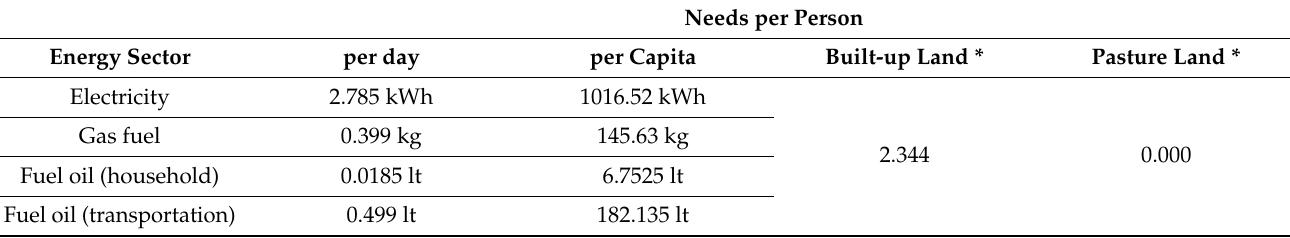
Table 7. Ecological footprint or land demand per person of the energy sector in Java Island. Needs per